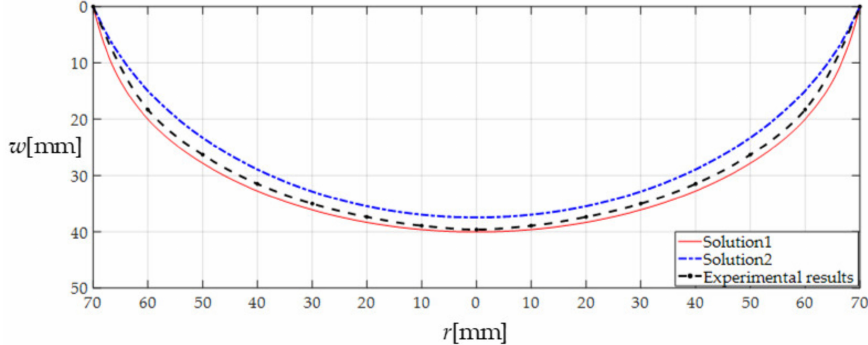
Figure 17. Membrane deflection along a diameter, experimental, and theoretical